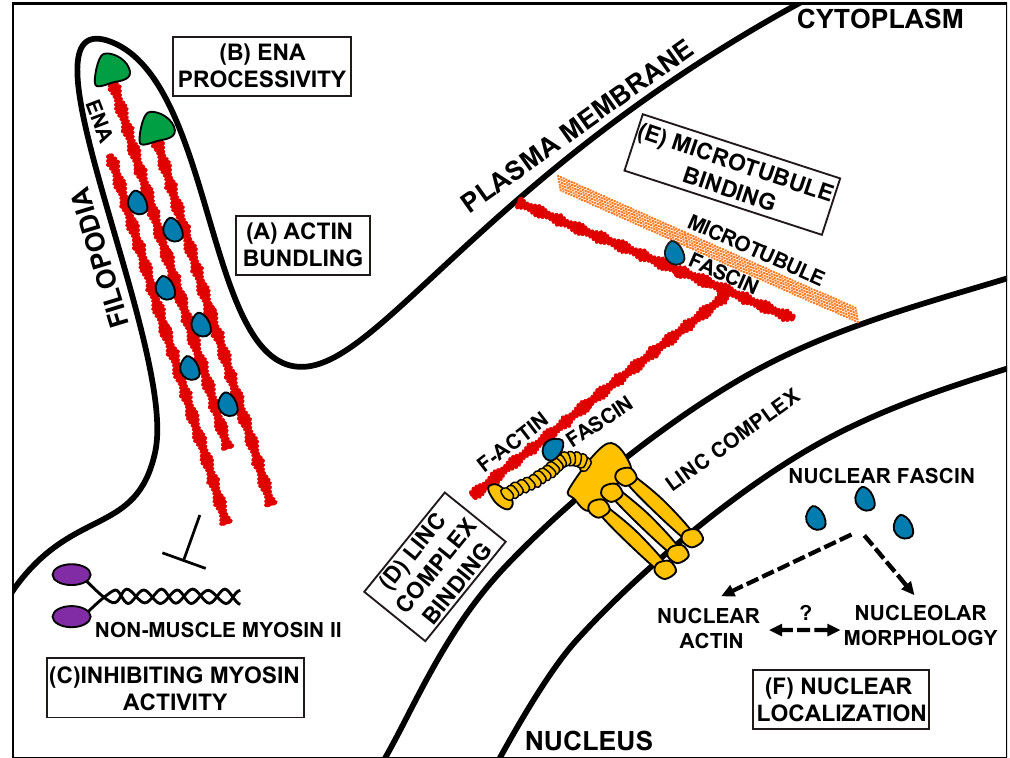
Figure 2. Schematic of the canonical and non-canonical functions of Fascin. Canonically, Fascin (blue) bundles actin filaments (red) to form structures such as filopodia ( A ). Fascin also regulates other actin-binding proteins, such as increasing the processivity of the actin elongating factor, Ena (green, B ), and inhibiting Non-muscle Myosin II (purple) activity ( C ). At the nuclear periphery, Fascin mediates mechanotransduction by interacting with the Linker of the Nucleoskeleton and Cytoskeleton (LINC) complex (gold, D ). In addition to binding actin, Fascin also binds to microtubules (orange, E ). Fascin also localizes to the nucleus, where it likely regulates nuclear actin and nucleolar morphology ( F ). Schematic is not drawn to scale.